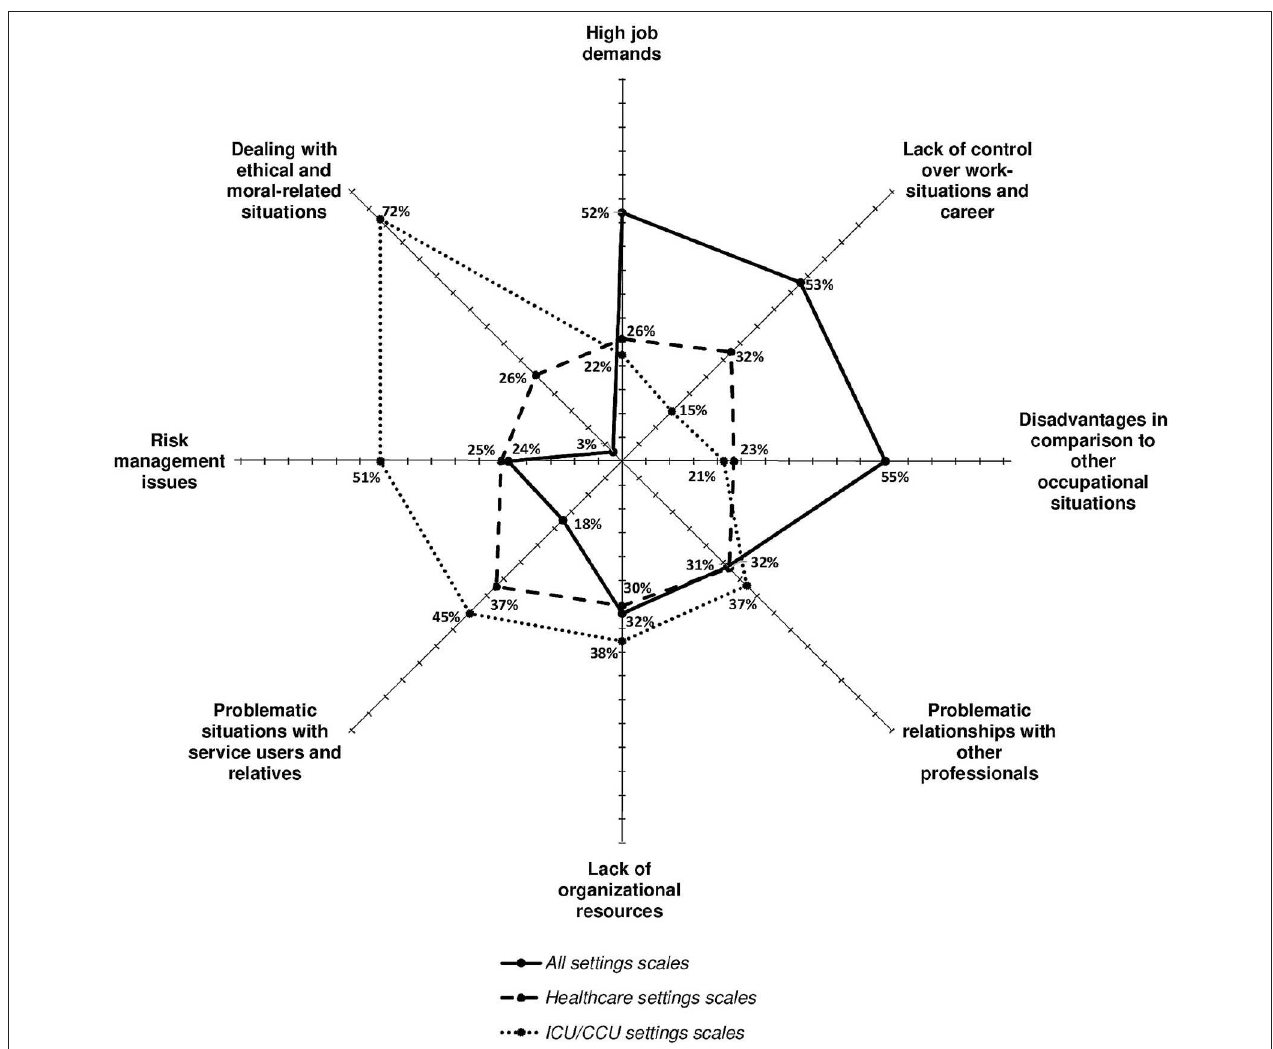
FIGURE 2 | Comparison of the three types of scales regarding their propensity to measure the eight broad types of stressors (% is the corrected proportion of scales of a type covering at least one stressor in the target category).